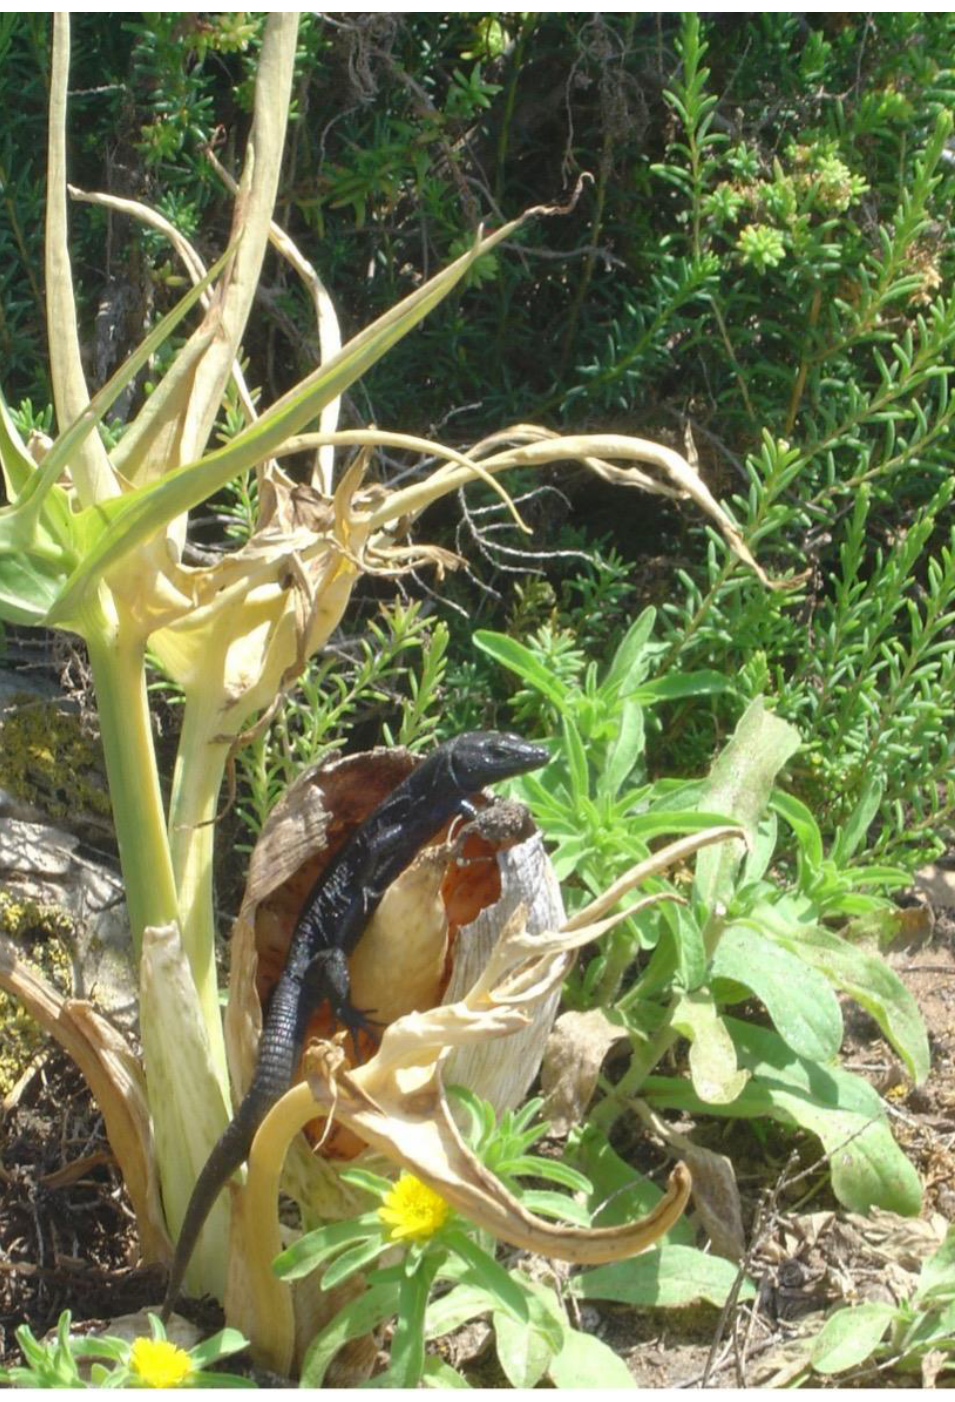
Figure 10. An intensely exploited infrutescence of dead horse arum with ripe fruits is visited by a female of the Balearic lizard.